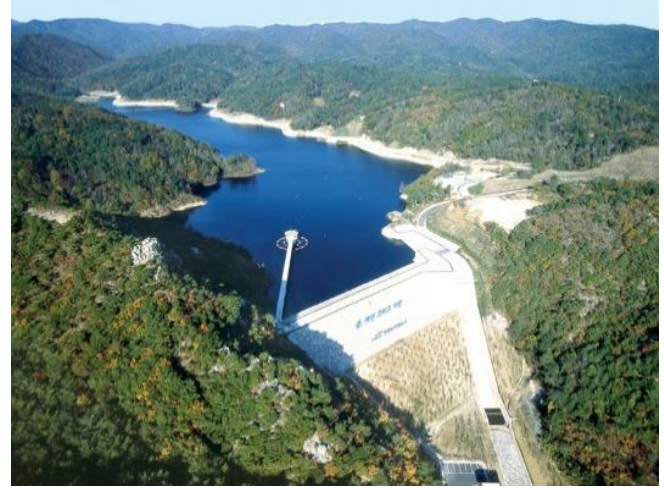
Figure 1. Study fill dam.